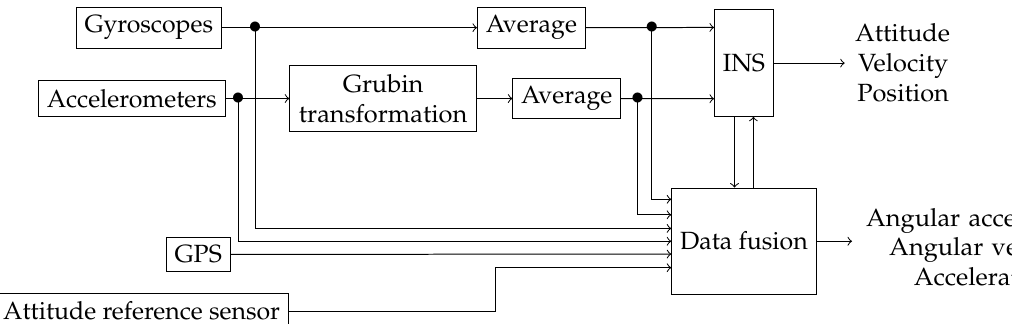
Figure 1. Structure of the fusion of multiple IMUs in one